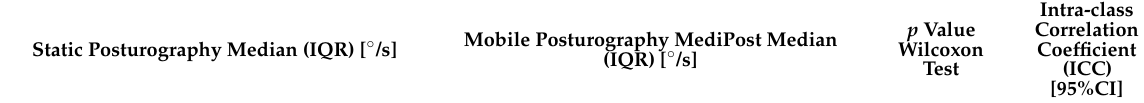
Table 2. Median values of angular velocity under four posturography conditions measured by mobile posturography (MediPost) and static posturography.